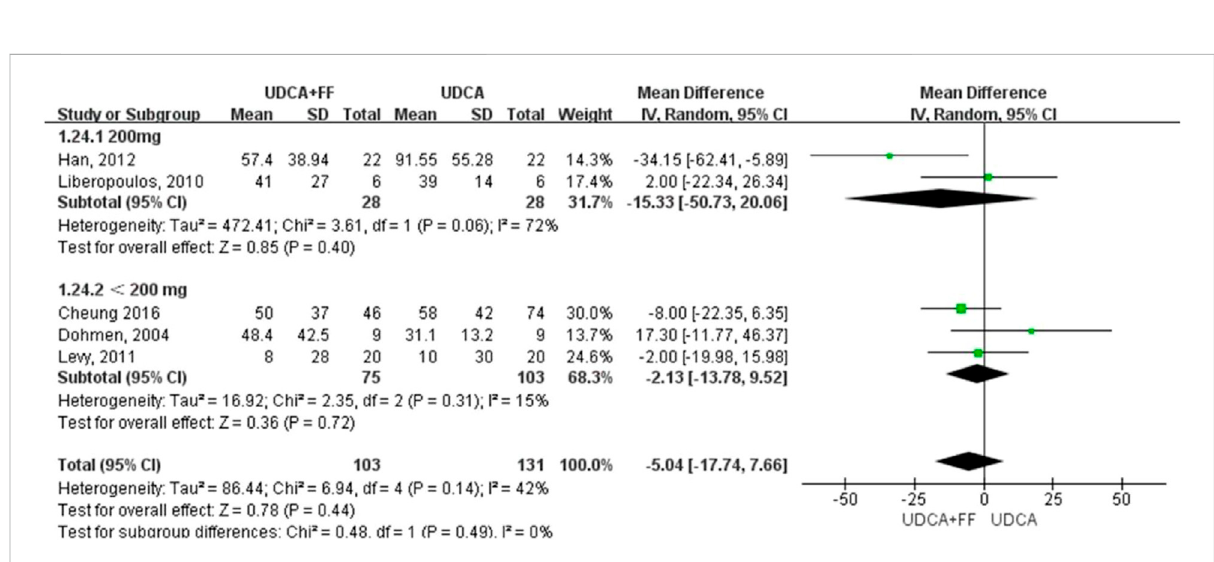
FIGURE 5 Subgroup analysis of ALP levels in PBC patients treated with monotherapy versus